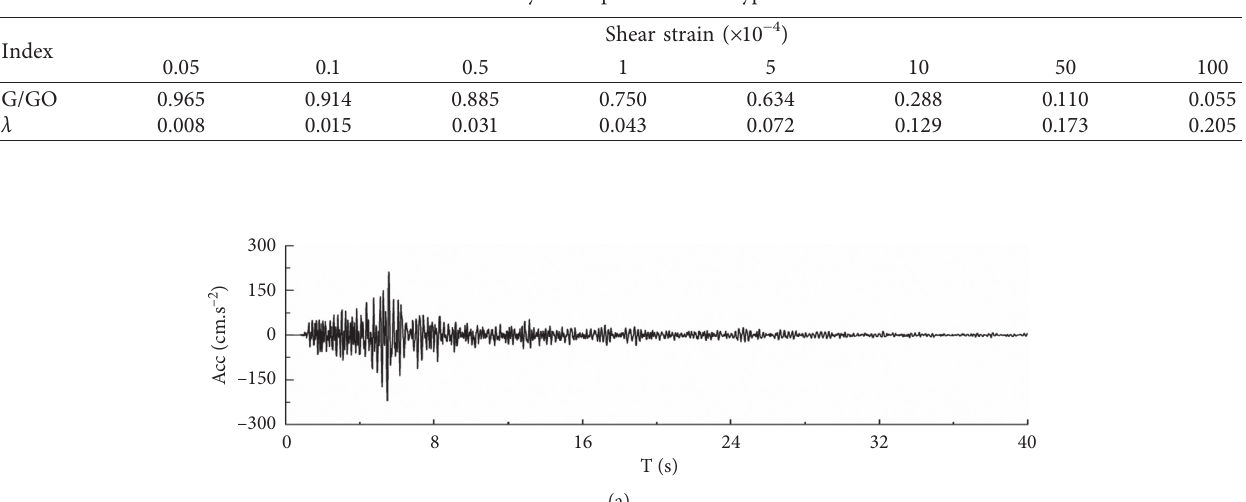
Table 1: The dynamic parameters of typical loess.